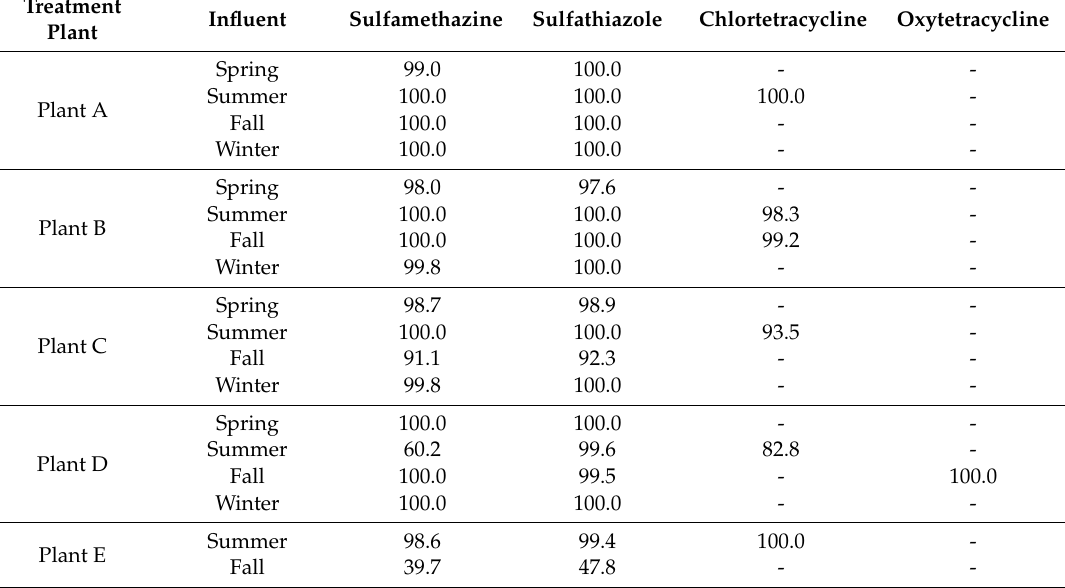
Table 8. Removal e ffi ciencies of livestock wastewater treatment